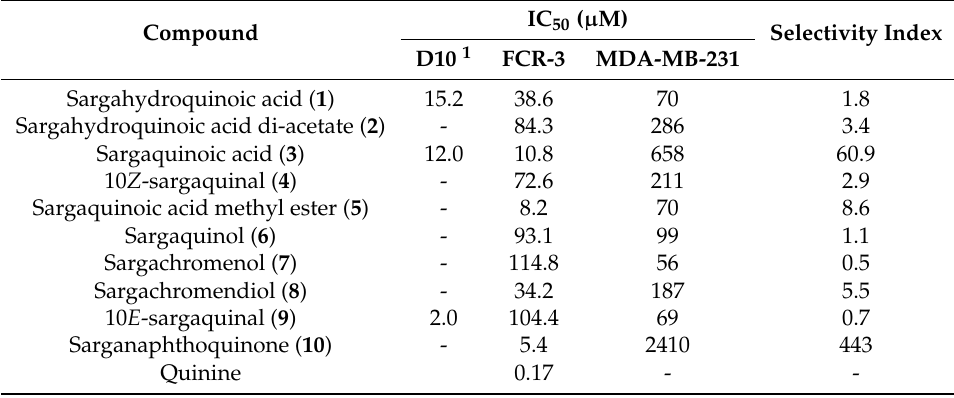
Table 2. Bioassay results for compounds 1 – 10